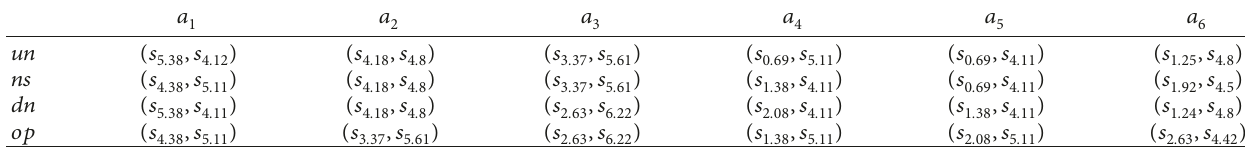
Table 5: Collective decision matrix with LFFWDHM operator.